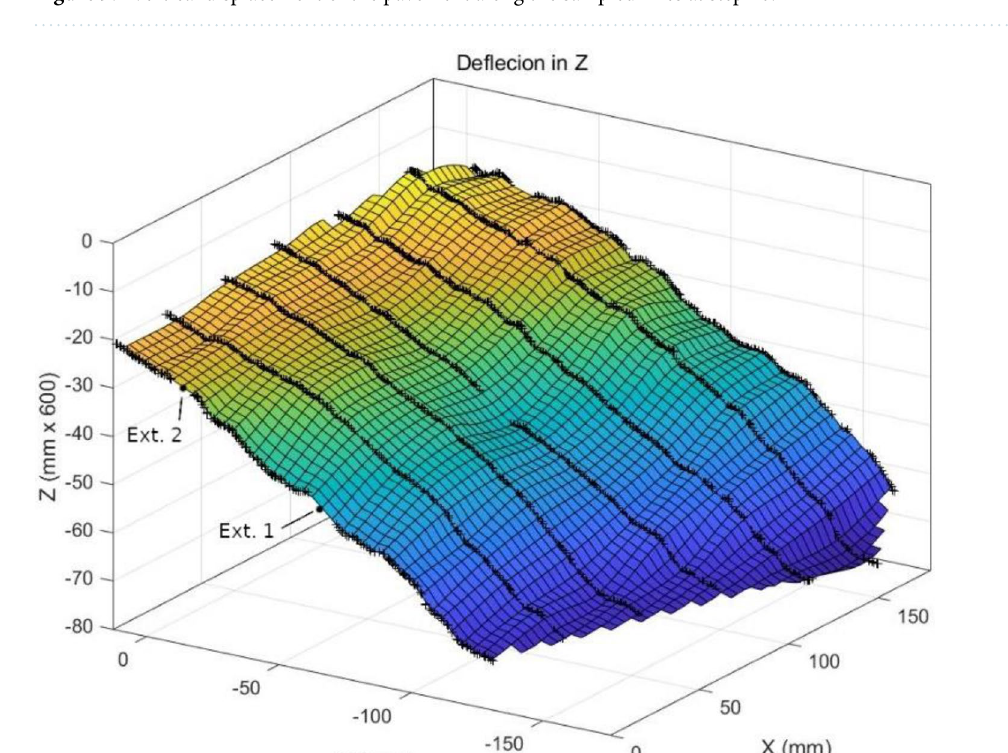
Figure 10. Deformed surface at step